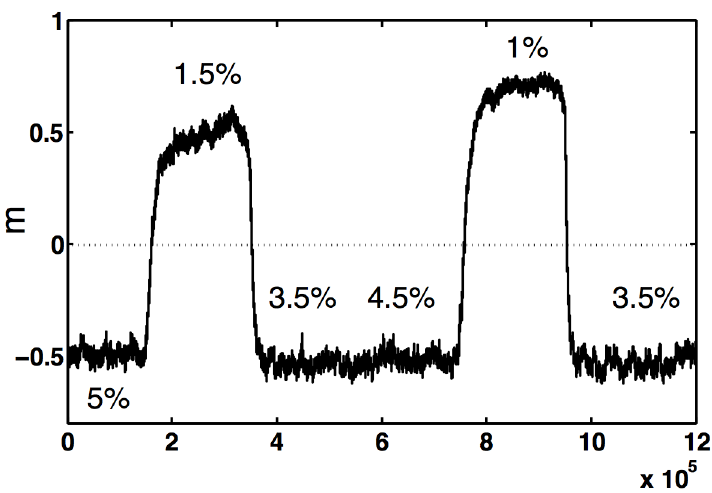
Figure 4. Strategy evolution under changing mutation rates. Order parameter m as a function of update time for an experiment with five changes in mutation rate, starting with a type adapted to a high mutation rate of 5% (defection regime). We show the order parameter for the average LOD of 80 runs with the same regime of mutation rate changes. The population reacts to a changed mutation rate quickly, and settles around the fixed point appropriate for that mutation rate, indicated in the figure.